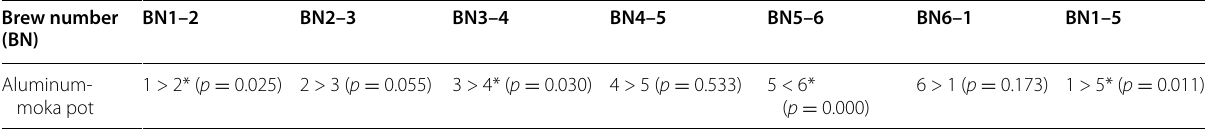
Pair-wise comparisons of coffees from the aluminum moka pots (independent of brand) dependent upon the number of times used to brew (BN) Significant differences are labeled with an*. The > (<) symbol shows in which of the comparison groups the arithmetic mean was higher (lower). α